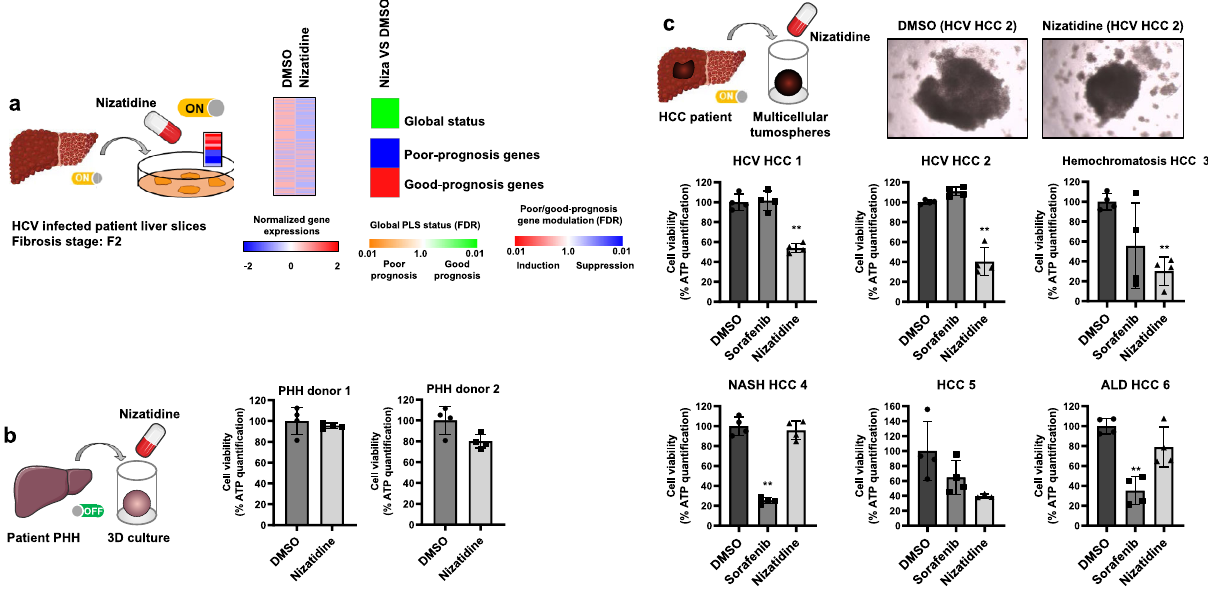
Fig. 8 Proof-of-concept for therapeutic impact of nizatidine in patient-derived tissues and cell culture models. a Nizatidine reverts the poor-prognosis PLS in culture of patient-derived tissue that were surgically resected from fi ve patients diagnosed with chronic hepatitis C (HCV). Detailed PLS gene expression pro fi les: heatmaps show the mean expression of the 186 gene signature. PLS was determined by GSEA analysis using DMSO treated tissues as reference. Simpli fi ed heatmaps show: (top) the classi fi cation of PLS status as poor (orange) or good (green) prognosis; (bottom) the signi fi cance of induction (red) or suppression (blue) of poor- or good-prognosis genes. FDR false discovery rate. b Absent effect on cell viability in PHH, assessed 4 days after nizatidine treatment in 3D culture. Each experiment shows mean ± SD in percentage compared to DMSO treated cells ( n = 4). c Nizatidine decreases HCC cell viability in a 3D patient-derived tumorspheroid model. HCC spheroids were generated from patient HCC tissues with different etiologies. Cell viability was assessed 4 days after treatment by measuring ATP levels. Each experiment shows mean ± SD in percentage compared to DMSO treated spheroids ( n = 4). * p < 0.05; ** p < 0.01, unpaired t test. The pictures show representative image of patient-derived tumorspheroids (magni fi cation ×40). NASH nonalcoholic steatohepatitis, ALD alcoholic liver disease. Source data are provided as a Source data fi